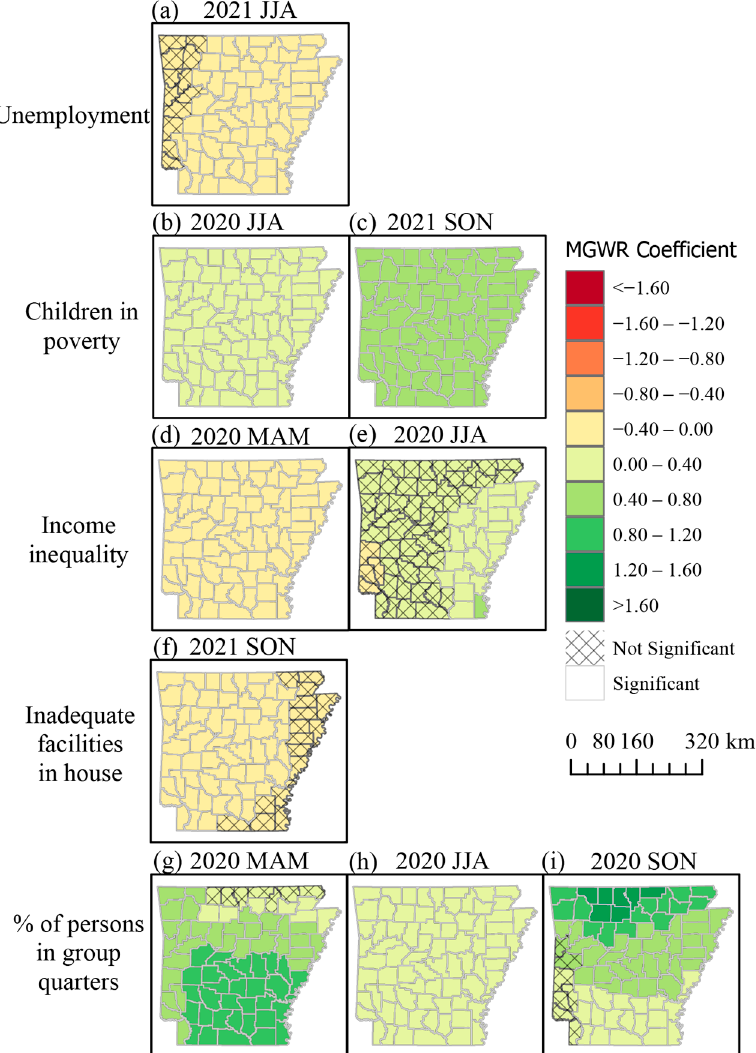
Figure 6. Spatial impacts of the socioeconomic variables on the COVID-19 rate derived from the multiscale geographically weighted regression model on COVID-19 in each county in Arkansas, US from 2020 to 2021. The unhatched regions indicate a 5% significance level. (MAM: March–April–May; JJA: June–July–August; SON: September–October–November; DJF: December–January–February).